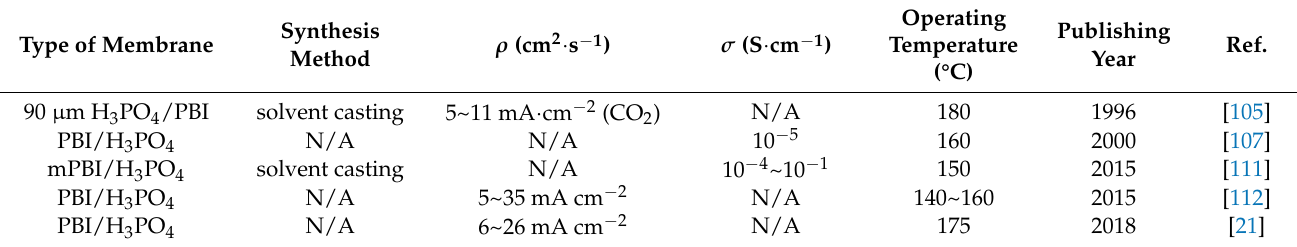
Table 3 listed the membrane properties of some representative studies on promoting the proton conductivity of PBI PEMs in DMFCs by PA doping. In addition to modifying the preparation methods of PBI PEMs, methods of synthesizing PBI with modified groups, applying nanomaterials, and using crosslinkers are also applied in promoting the acid retaining properties of PBI in high-temperature DMFCs, the relative works are introduced in the next section. Table 3. The membrane properties of some representative studies on promoting the proton conductivity of PBI PEMs in DMFCs by PA doping.